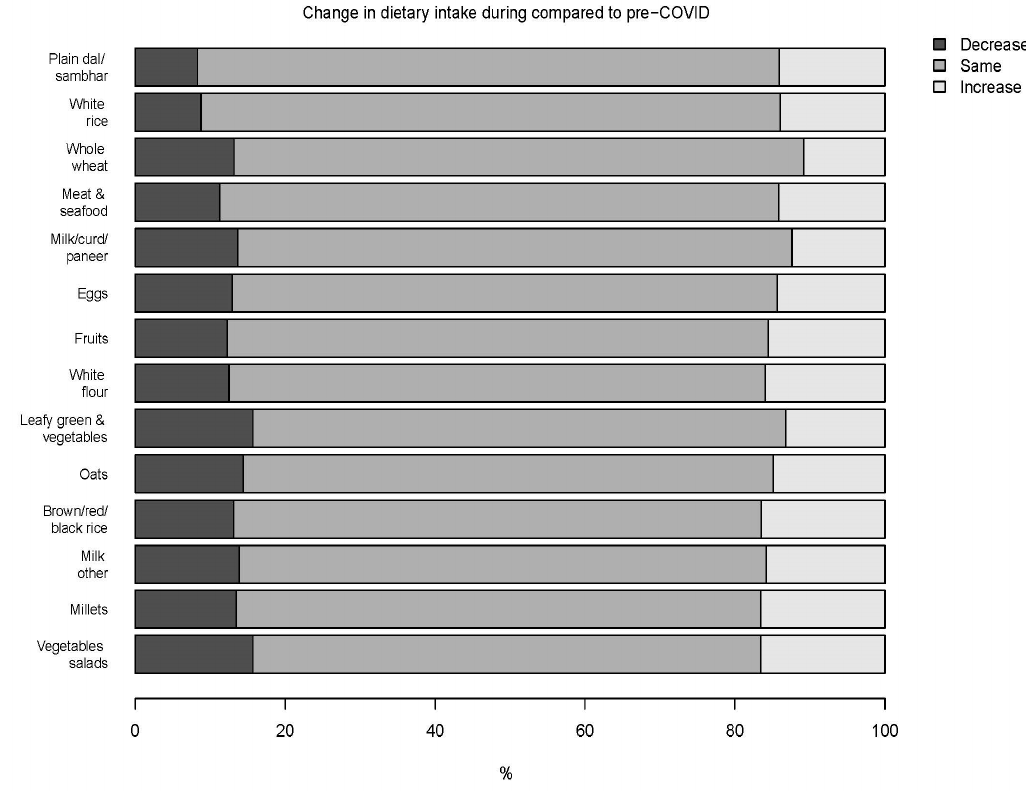
Figure 1. Percentage of participants reporting a decrease, no change (same), or increase in intake frequencies of 14 food groups during the COVID ‐ 19 confinement compared to pre ‐ COVID ‐ 19. Table 2. The change in self ‐ reported intake frequency of 14 food groups during the COVID ‐ 19 confinement compared to pre ‐ COVID ‐ 19 *.